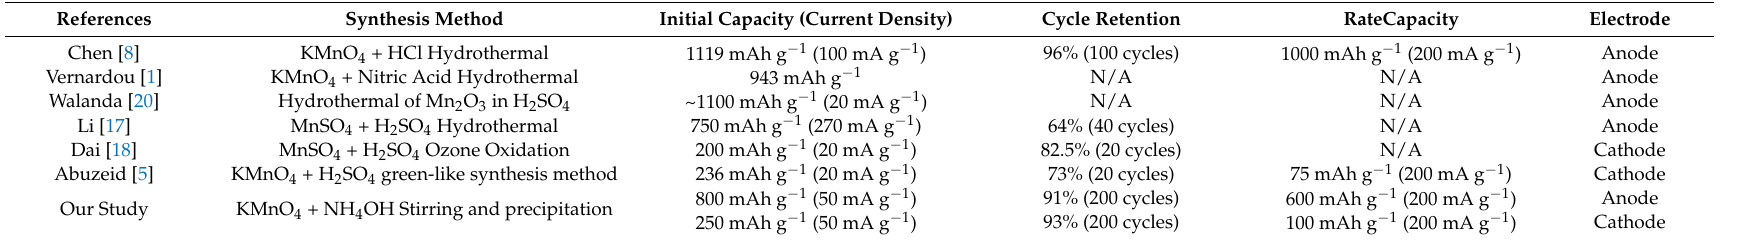
Table 1. Comparison of current work to literature reports on MnO 2 in lithium ion